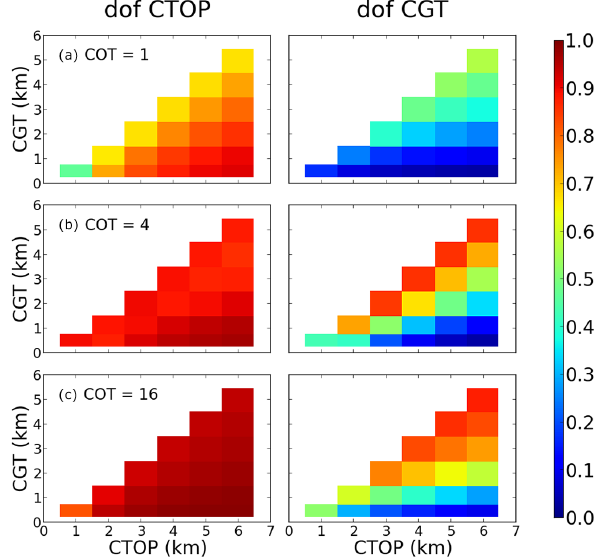
Figure 20. Same as Figs. 14 and 19 with an albedo of 0.8. There is an interesting increase in information content for the moderately opaque (COT = 4) clouds when they are relatively thick, e.g. CGT ≥ max { 2,CTOP-2 }